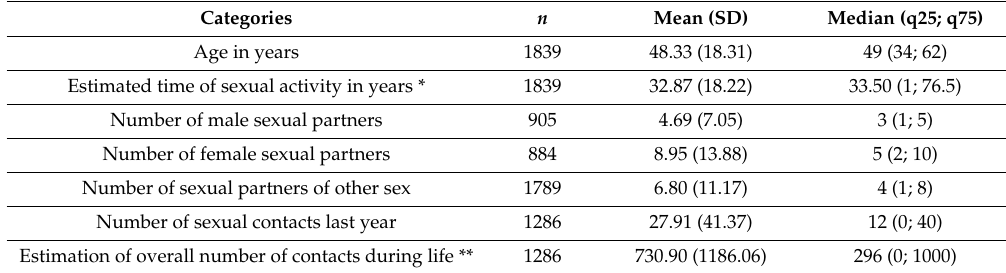
Table 1. Data on sexual behavior in Germany as derived from the study by Haversath et al. [2]. Only individuals from the Haversath study with exclusively heterosexual sex partners according to self-disclosure were